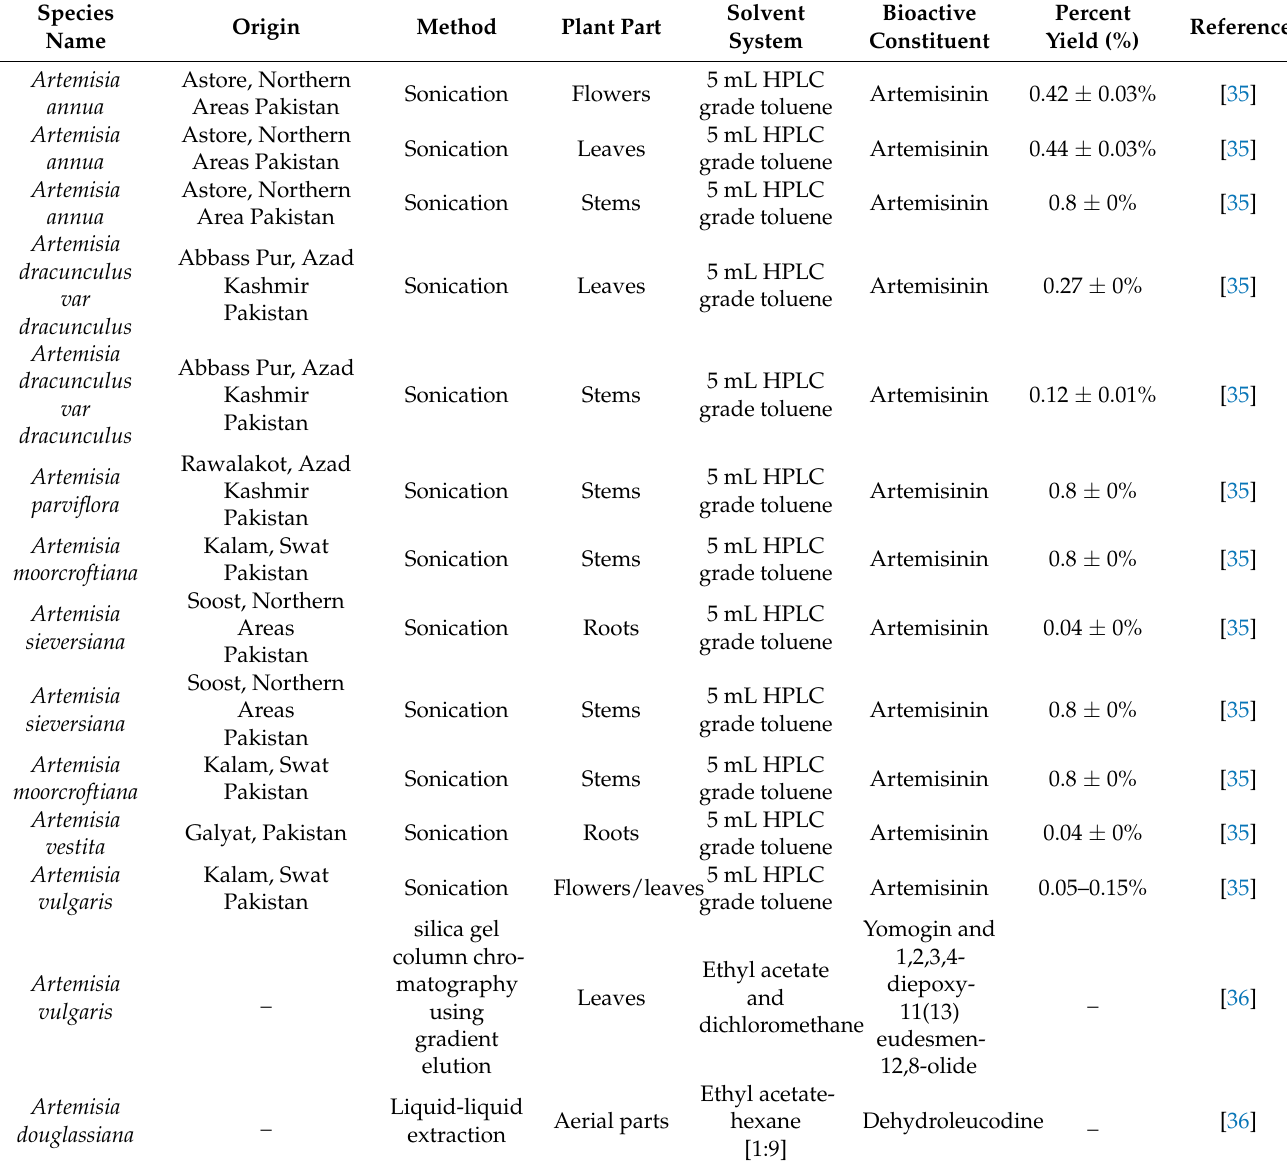
Table 1. Bioactive compound extraction techniques for Artemisia